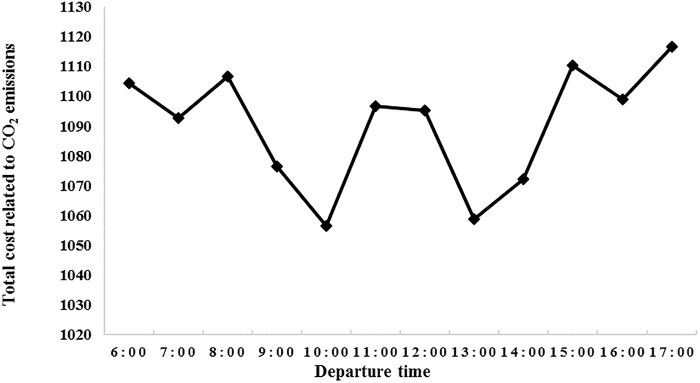
Relationship of CO2 emissions and departure time.